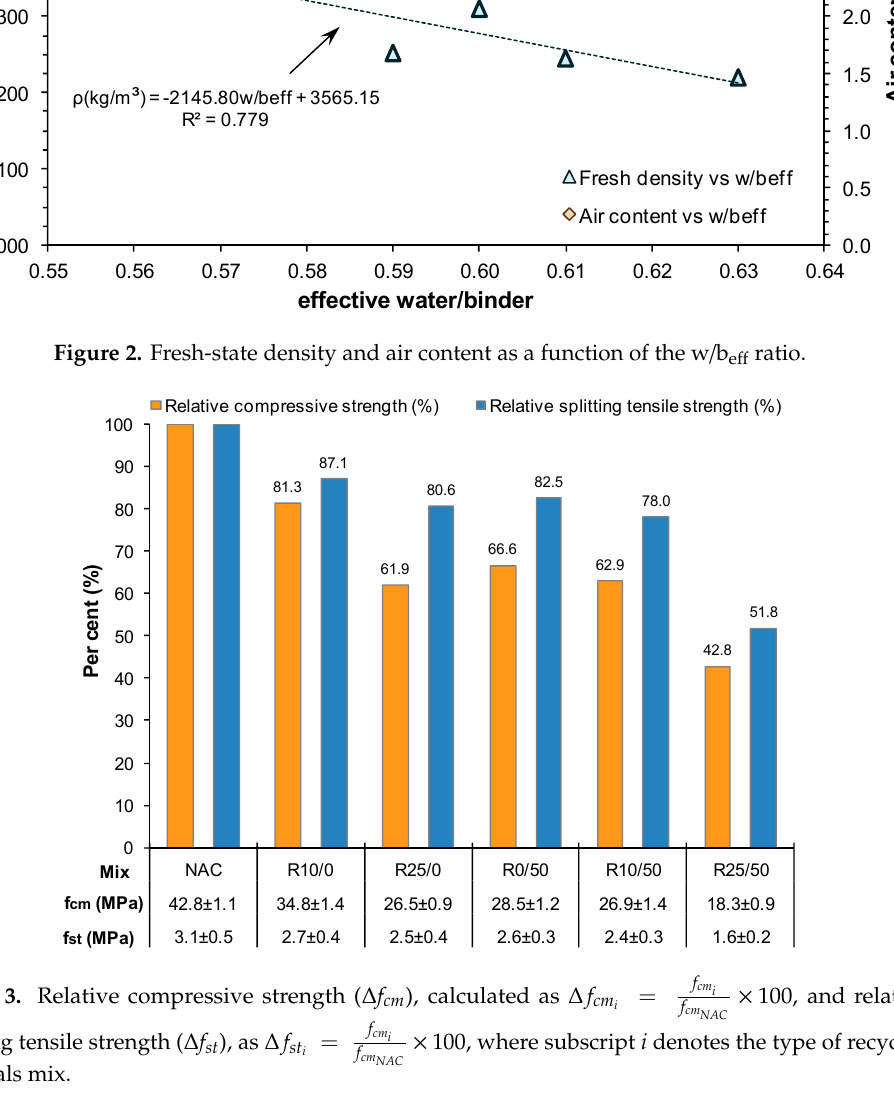
and 19.4% in tensile strength relative to NAC, due to the lower reactivity of GRC relative to